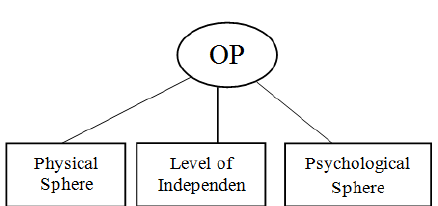
Figure 3. Correlation relationships of the indicator “OP” of the teachers’ group 2 Note: correlation at a significance level of 0.05. correlation at a significance level of